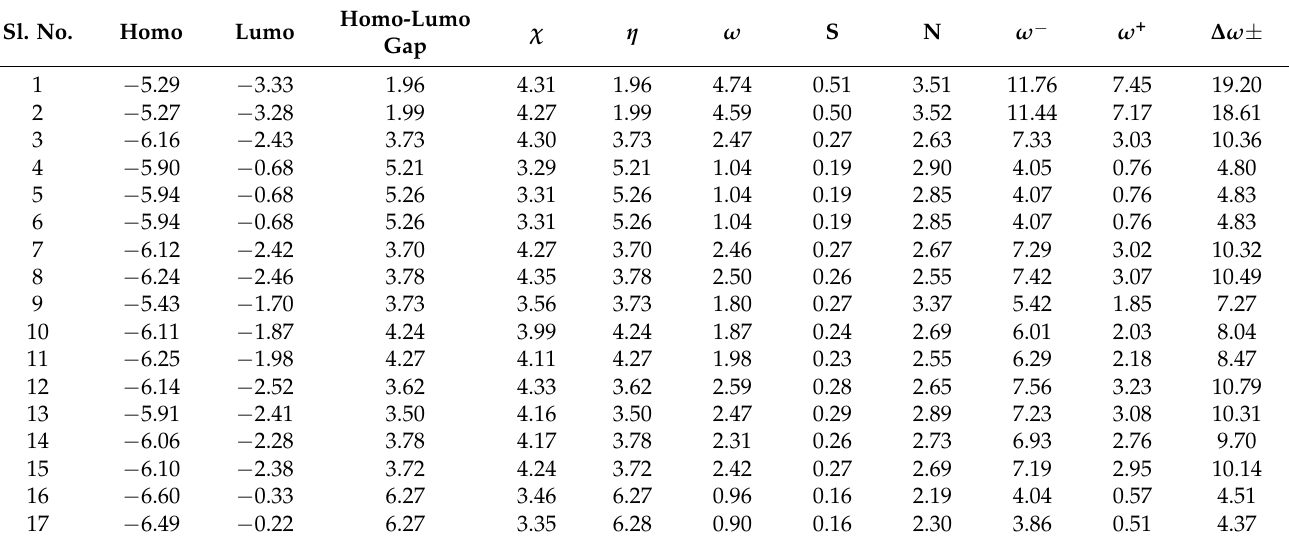
Table 2. CDFT Global Reactivity Descriptors of the Selected Potential